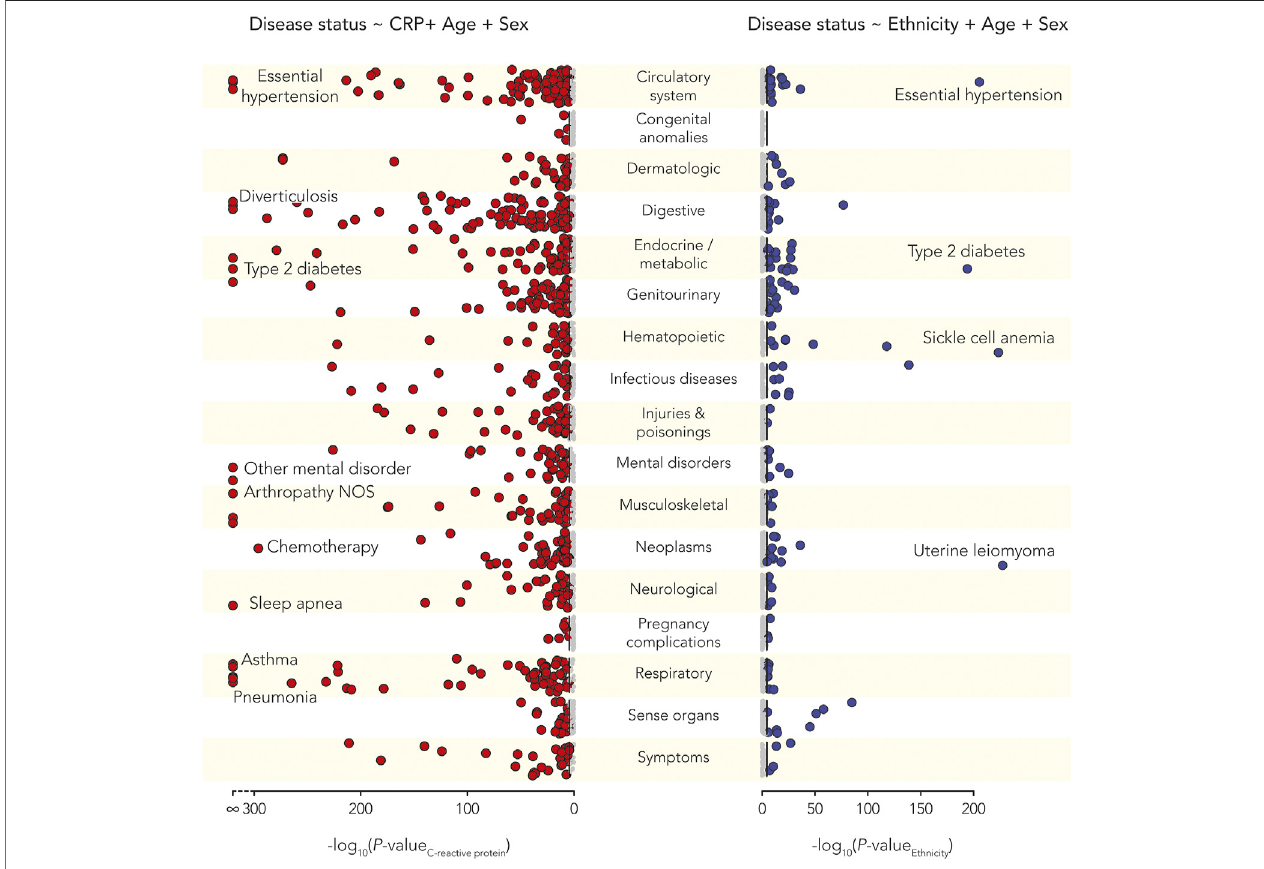
FIGURE 4 | C-reactive protein (CRP) and ethnic health disparities. Manhattan plots showing the statistical signi fi cance levels (-log 10 p -values) for associations of disease and CRP (left, red circles) and associations of disease and ethnicity (right, blue circles). Diseases are categorized as shown using the phecode scheme. Bonferronicorrected p -valuethresholdsareshownwithblacklines.Bonferronicorrectedsigni fi cantassociationsareindicatedwithlarger,darkcirclesandselectdisease examples are annotated as